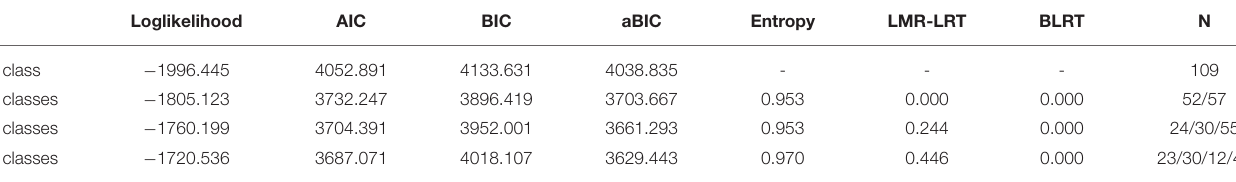
TABLE 1 | Model fit information. Loglikelihood